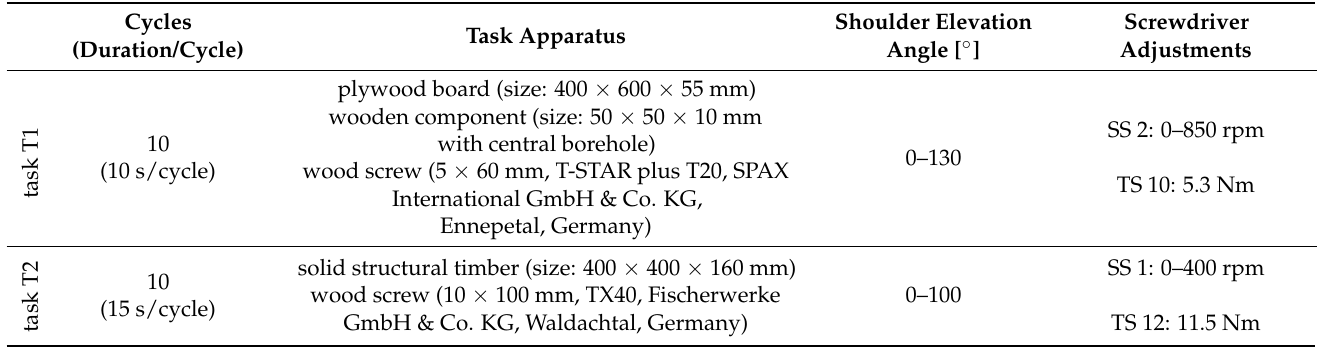
Table 2. Task specifications and details.